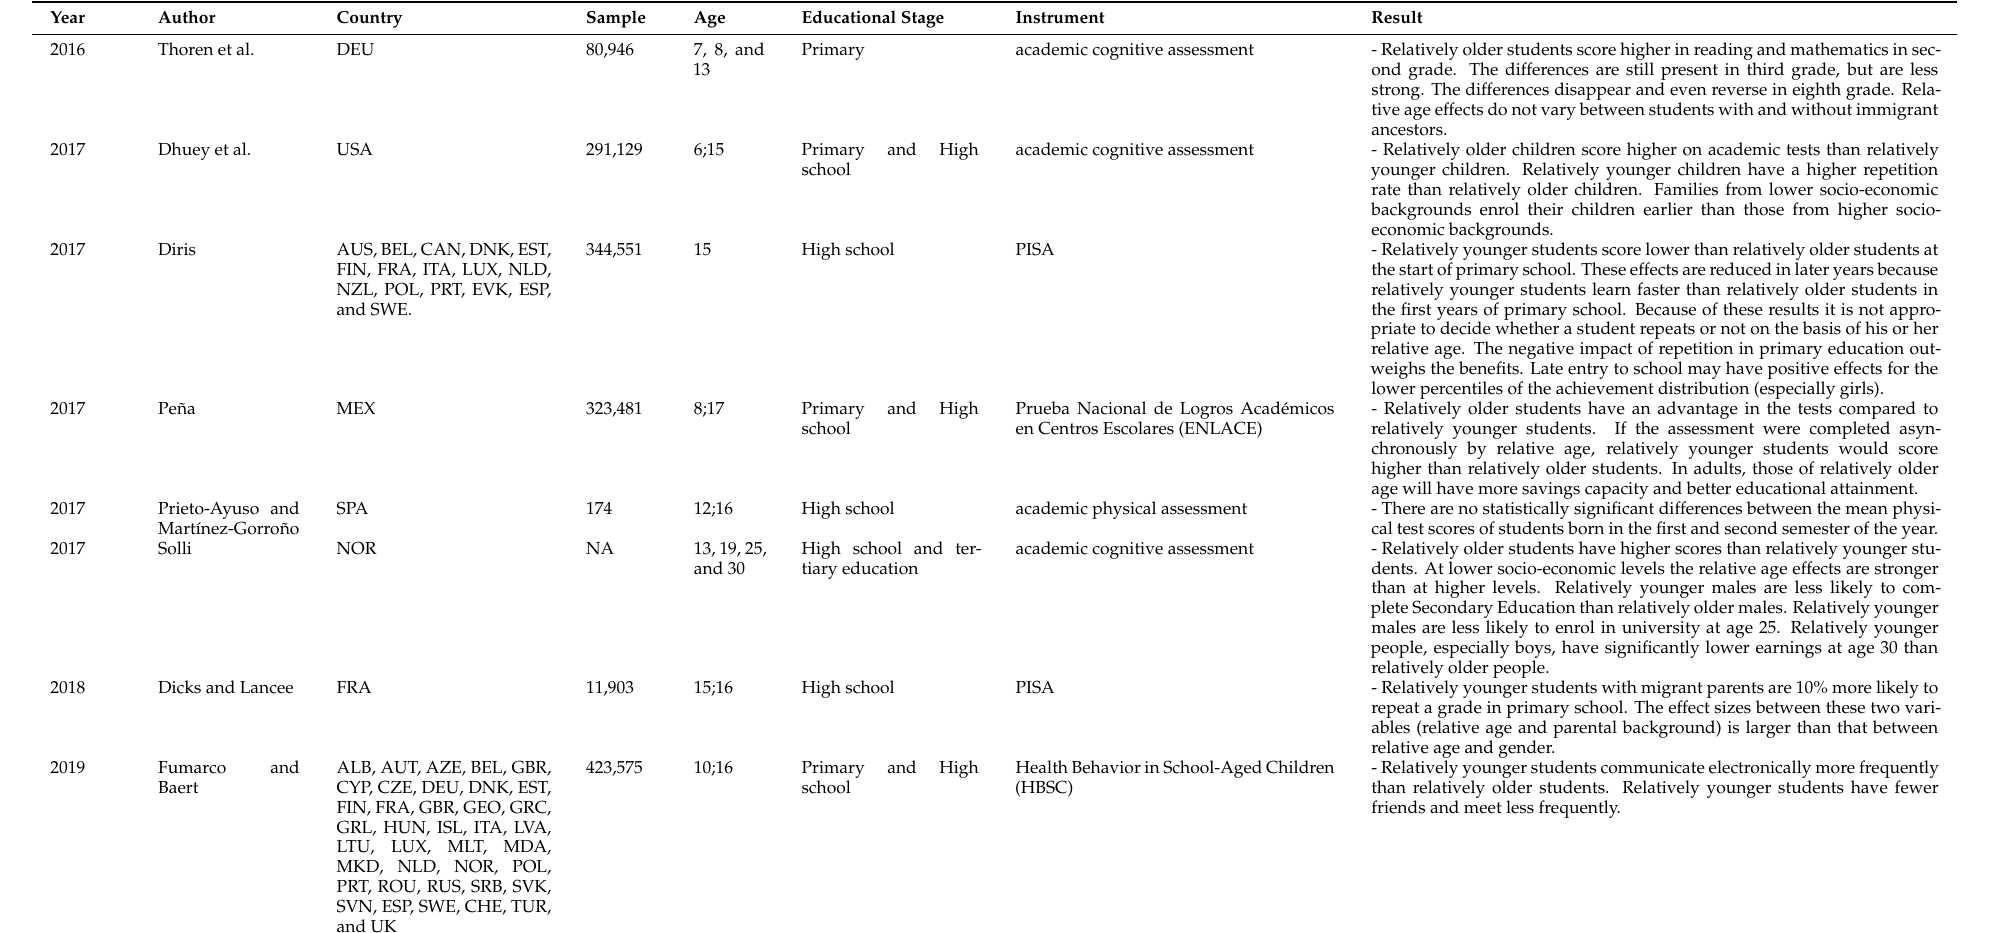
Table 2. Scientific articles taken into account in the systematic review (part